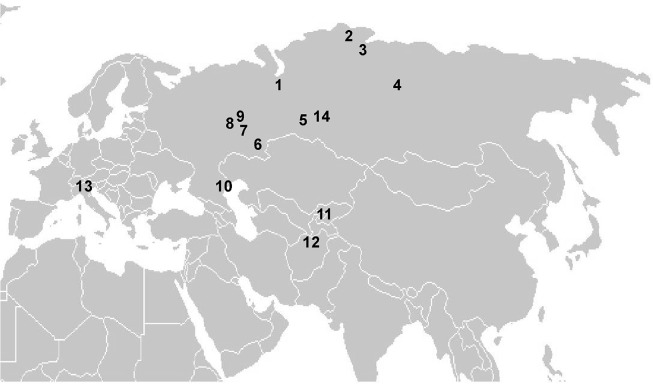
Geographic localization of modern Eurasian human populations with mtDNA haplogroup A10 lineages in gene pools.1—Mansi [21]; 2—Nganasans [22]; 3—Dolgans [22]; 4—Evenks [22]; 5—Siberian Tatars [23]; 6—Bashkirs [24]; 7—Tatars [18, 24]; 8—Chuvash [24]; 9—Mari [24]; 10—Nogays [25]; 11—Tadjiks [22]; 12—Afghanistan Hazara and Uzbeks [20]; 13—population of Italian Alps [19]; 14—ancient Baraba forest-steppe populations.